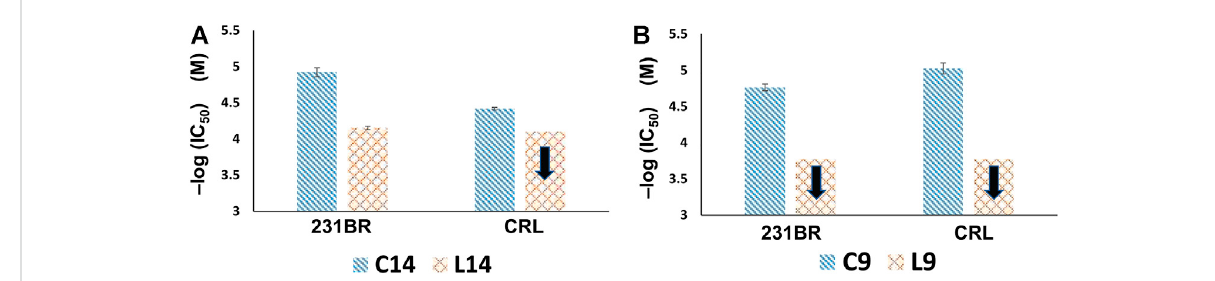
FIGURE 6 Anticancer activity comparisons of (A) C14 and L 14 , and (B) C9 and L 9 . The black arrow denotes that the anticancer activity is lower than the corresponding value because the concentration in cytotoxicity test could not set higher due to the solubility issue. The copper(I) complexes signi fi cantly increase the anticancer activity compared with their relevant